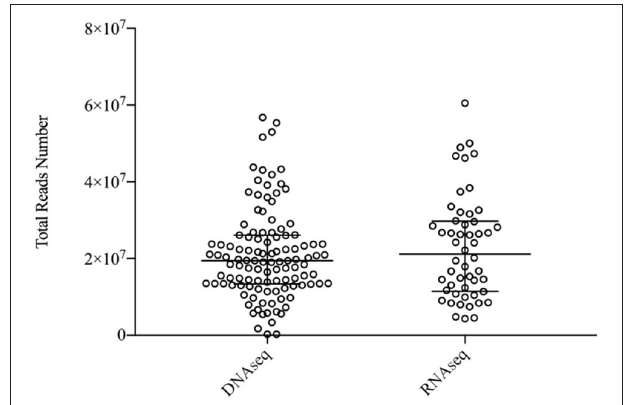
FIGURE 1 | Total sequencing reads of the reports of a total of 149 patients counted to the final analysis.